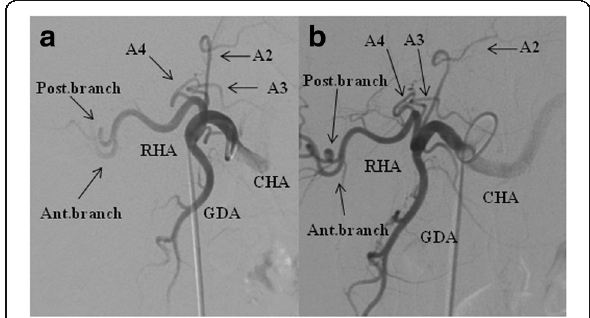
Fig. 2 Angiography showing the segment II, III, and IV (A2, A3, and A4 with arrows , respectively) arteries individually originated from the proper hepatic artery like the simulation. In a the front view and b the left anterior oblique view. CHA common hepatic artery, GDA gastroduodenal artery, RHA right hepatic artery, Post. branch posterior branch of RHA, Ant. branch anterior branch of